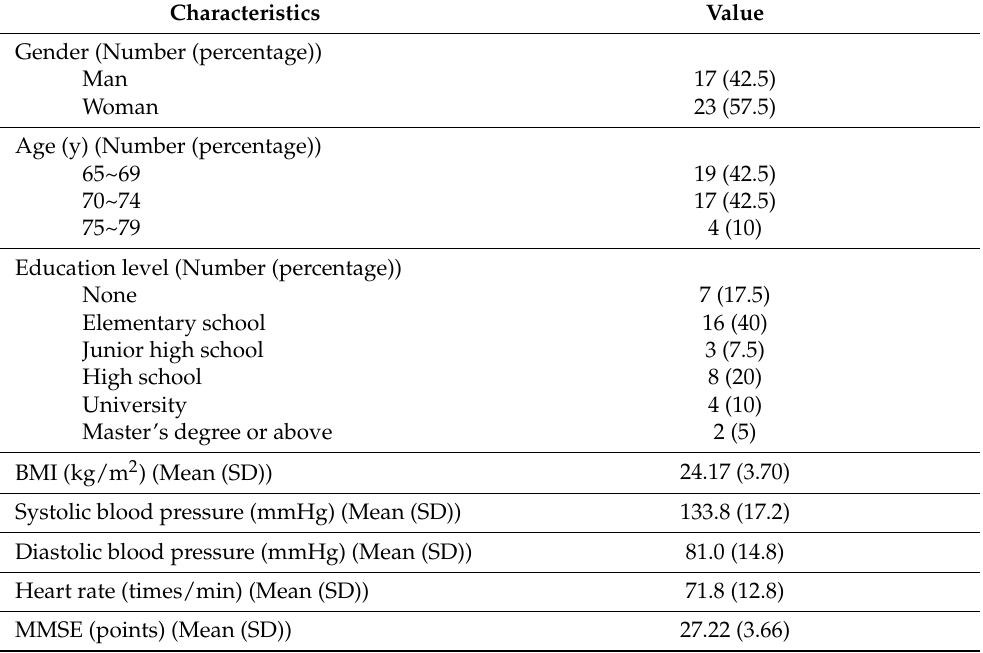
Table 1. Participant